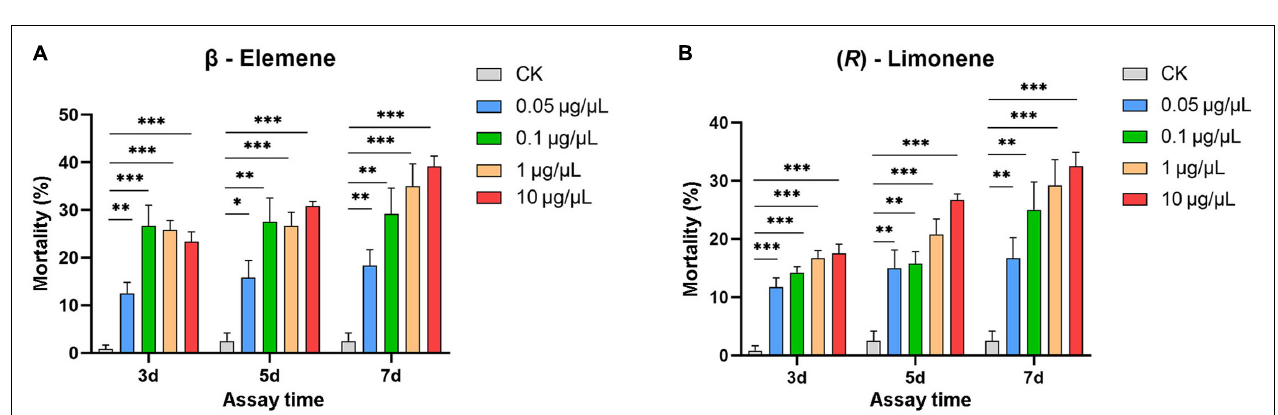
FIGURE 8 | Larval mortality of Helicoverpa armigera caused by β -elemene (A) and limonene (B) . Data were tested to evaluate differences using Student’s t -test (* P < 0.05; ** P < 0.01; *** P <